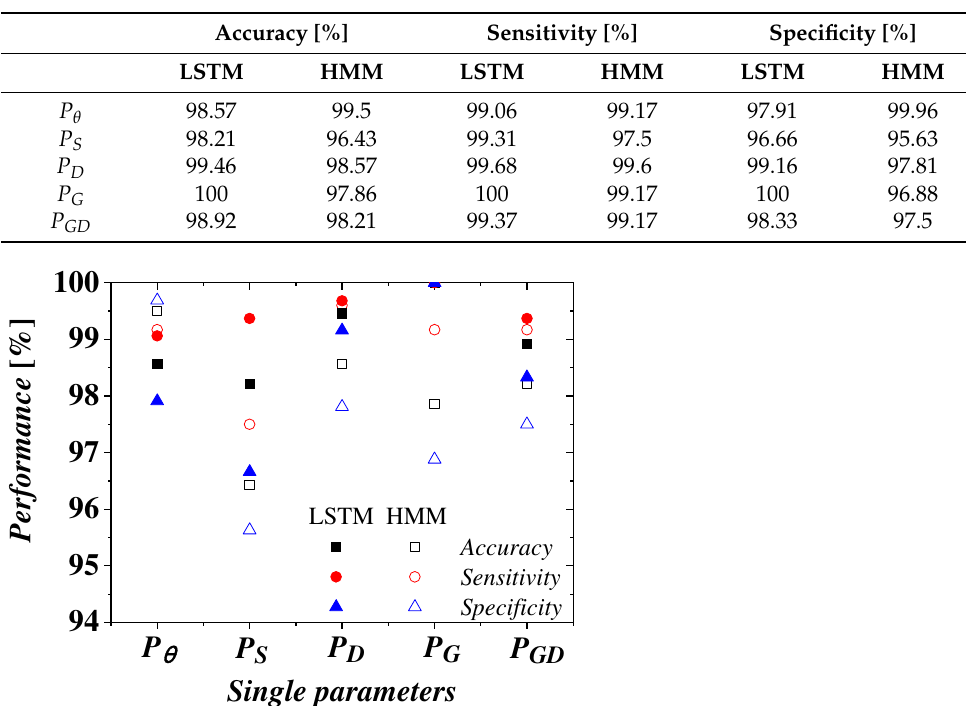
Figure 6. Confusion matrix applying 5-types of single parameter to the proposed LSTM-based fall detection system. ( a ) P θ , ( b ) P S , ( c ) P D , ( d ) P G , ( e ) P GD. Table 4. Fall detection results of the proposed STM-LSTM-based and the previously reported STM- HMM-based fall detection systems, applying the single parameters.